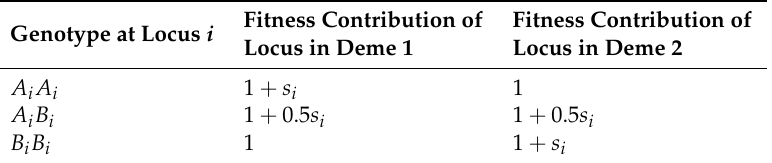
Table 3. Fitness scheme for loci under